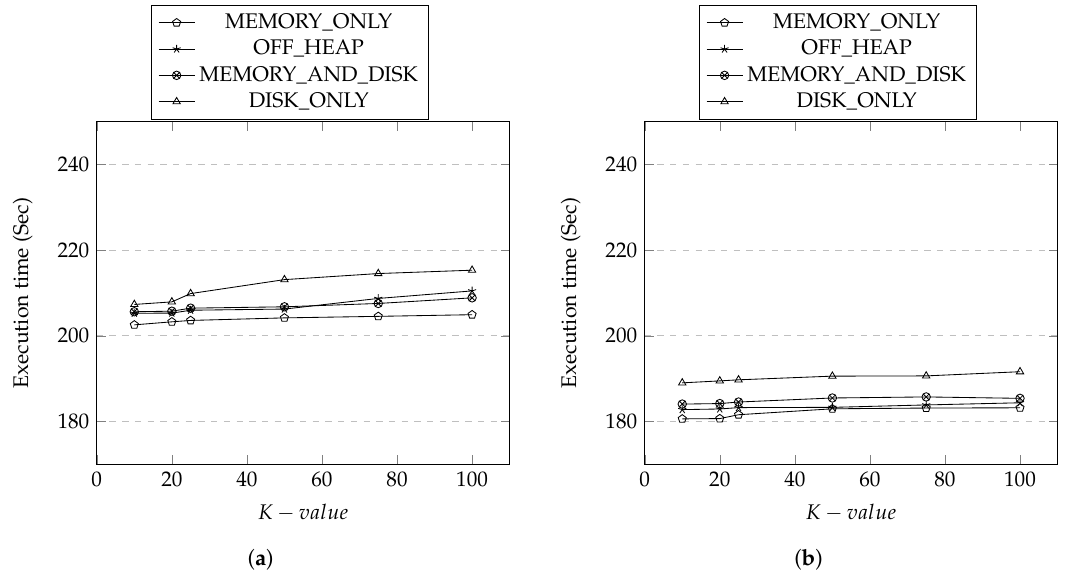
Figure 12. Execution Time vs. Cache Strategies. ( a ) Adult Dataset; ( b ) Irish